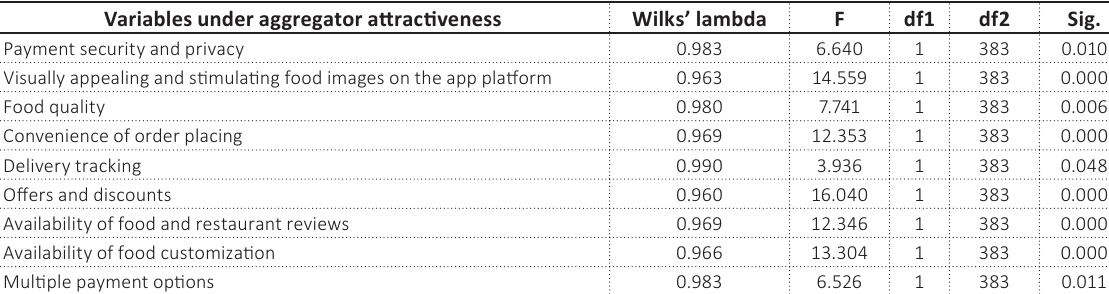
Table 2. Discriminant analysis of aggregator attractiveness